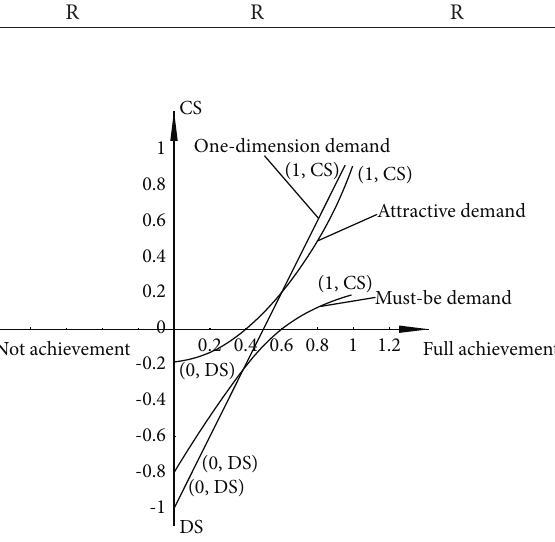
Figure 3: The function curve of customer satisfaction and CR